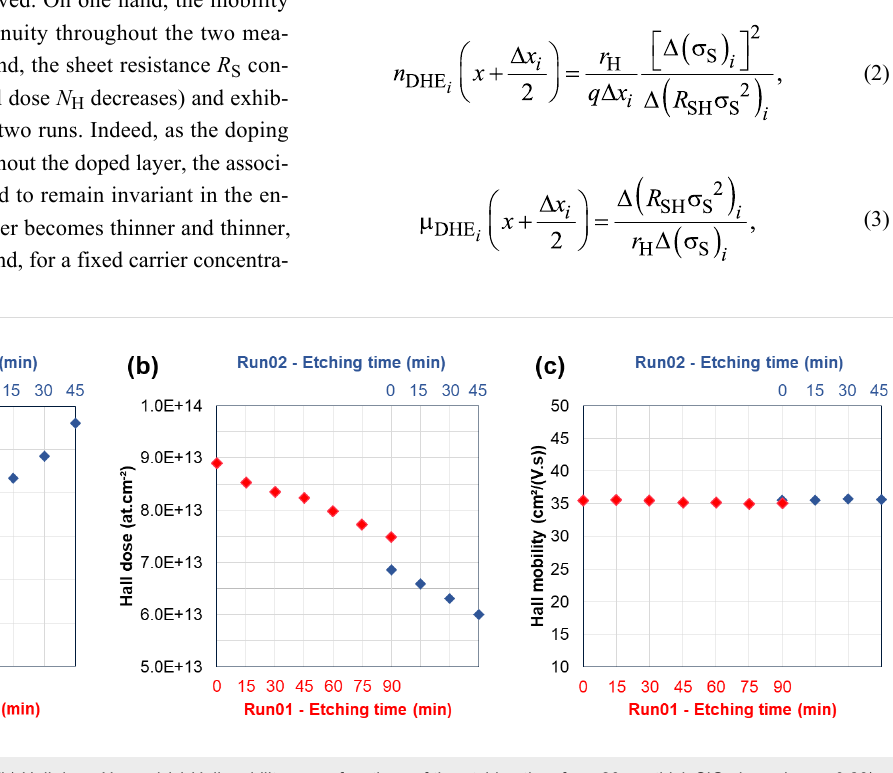
Figure 3: (a) Sheet resistance R S , (b) Hall dose N H , and (c) Hall mobility µ H as functions of the etching time for a 20 nm thick SiGe layer ( x Ge = 0.23) grown by CVD and in situ doped with